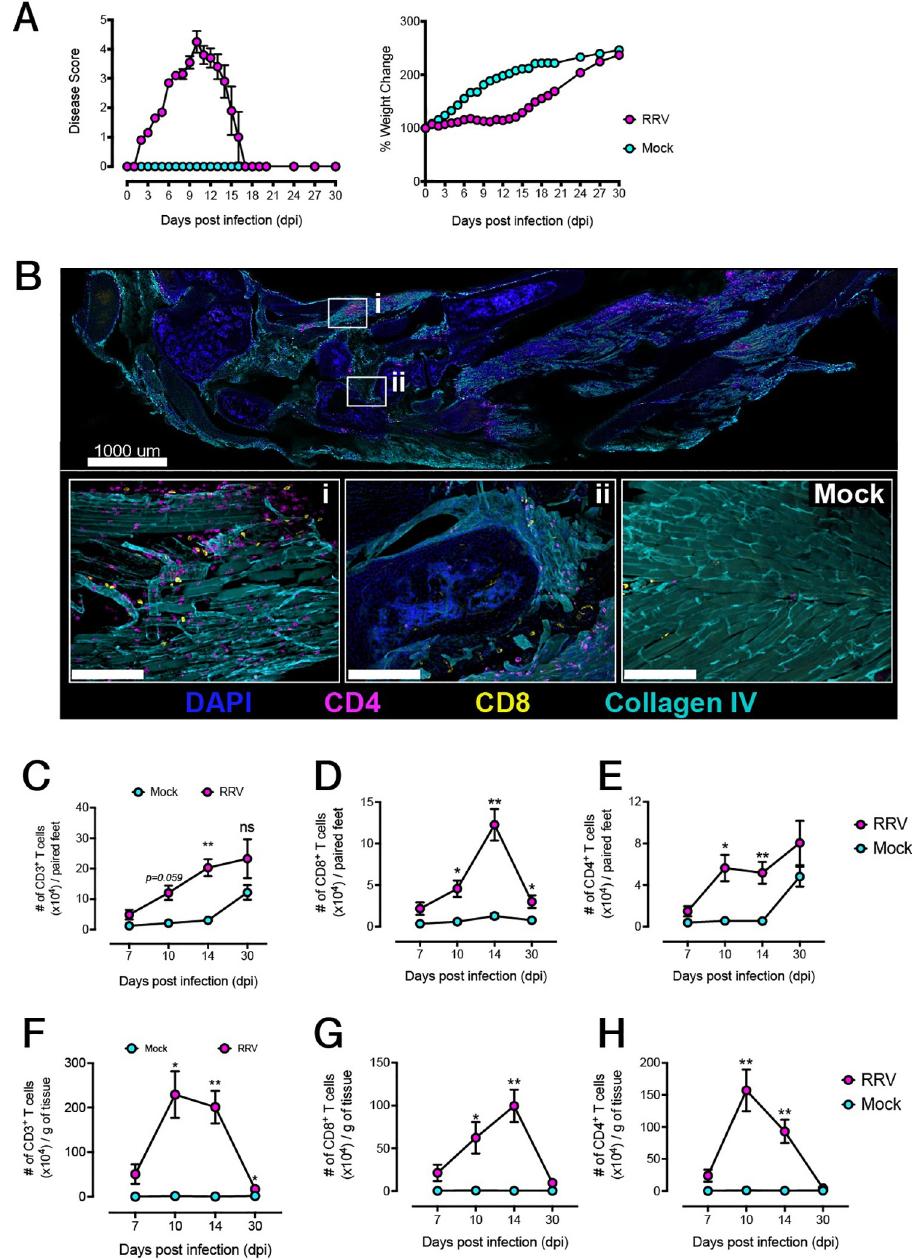
Fig 2. RRV-induced musculoskeletal inflammation is associated with T cell infiltration in the joints and muscle. A) Disease kinetics of IL-17 GFP mice infected with RRV T48 . Mice were monitored for signs of disease and weight loss as described in Materials and Methods until 30 days post-infection (dpi). Data shown (mean +/- SEM) for 3 pooled independent experiments (n = 5 mice per group). B) Immunofluorescent microscopy of sagittal cryosection of the hindfoot of an RRV-infected IL-17 GFP mouse, at 10 dpi. Nuclei were stained with diaminido-2-phenylindol (DAPI), connective tissue was labelled using an anti-Type IV collagen antibody, and T cells labelled using anti-CD4 and anti- CD8 antibodies. Insets show the localization of infiltrating CD4 + and CD8 + T cells in the (i) interarticular muscle tissue and (ii) tenosynovium of RRV- and mock-infected mice. Data representative of 3 independent experiments (n = 4–5 mice per group). C) Quantification of CD3 + T cell infiltrates in the feet of mock-infected mice and RRV- infected IL-17 GFP mice at 7, 10, 14 and 30 dpi by flow cytometry. Data shown (mean +/- SEM) as number of LIVE CD45 + CD3 + T cells per paired feet. D) Quantification of CD8 + and E) CD4 + T cell infiltrates in feet of mock-infected mice and RRV-infected IL-17 GFP mice at 7, 10, 14 and 30 dpi by flow cytometry. F ) Quantification of CD3 + T cell infiltrates in the quadriceps muscle of mock-infected mice and RRV-infected IL-17 GFP mice at 7, 10, 14 and 30 dpi by